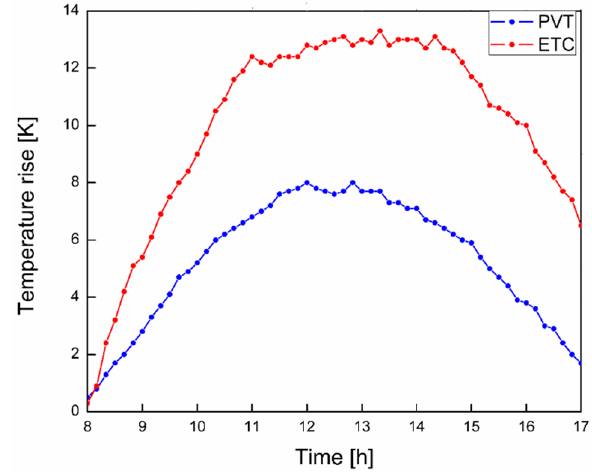
Figure 4. Variation of working fluid temperature rise in each collector type.